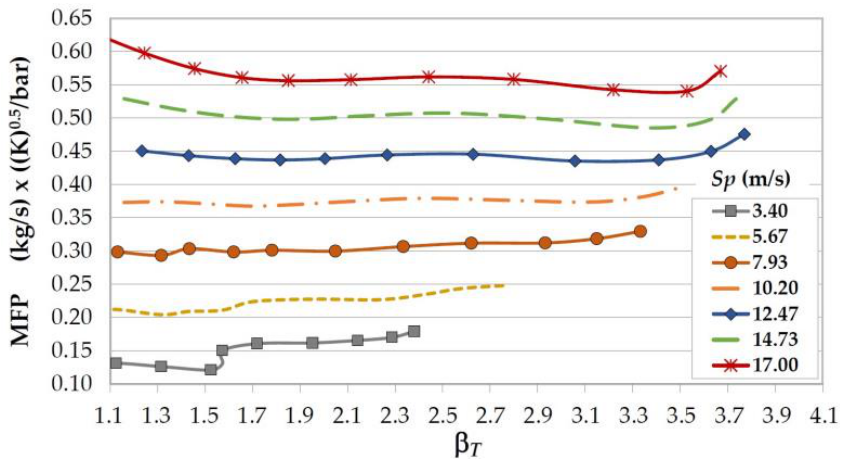
Figure 2. Operating parameters of the exhaust gas turbine considered in the separated electric compound engine studied in [2] (mass flow parameter as a function of turbine pressure ratio β T ).